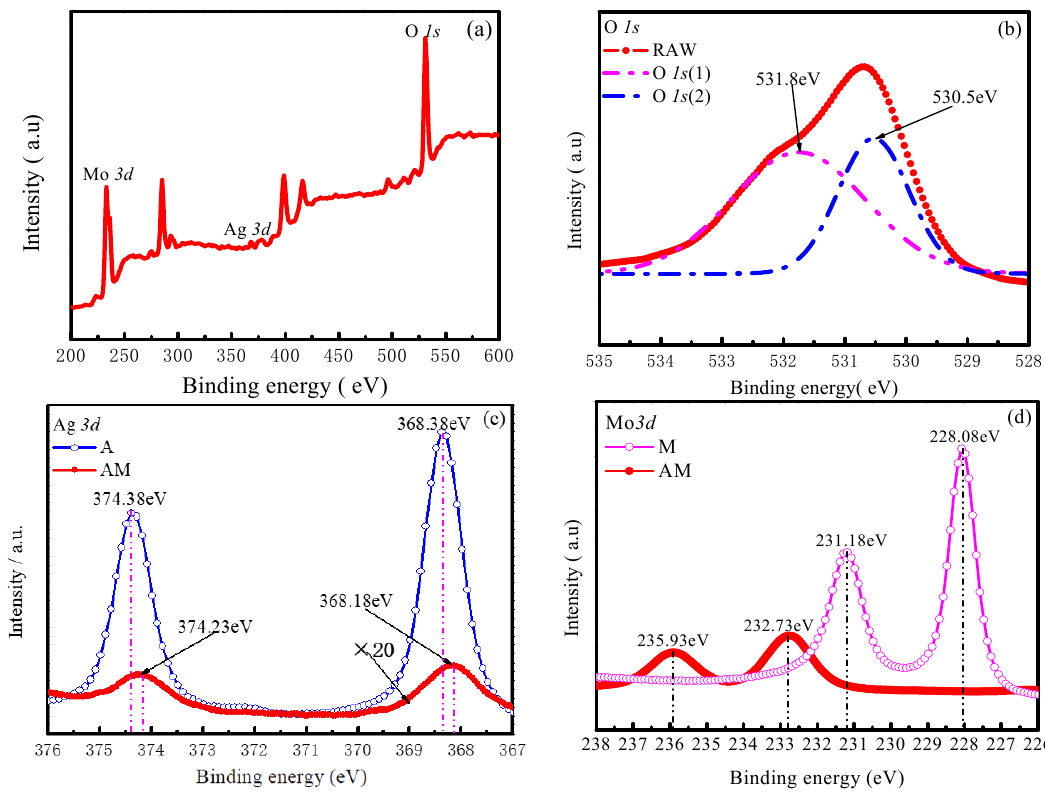
Figure 3. ( a ) XPS full spectra; ( b ) O1s XPS spectra for AM; ( c ) Ag3d XPS spectra of A and AM; and ( d ) Mo3d XPS spectra of M and AM before the wear test.